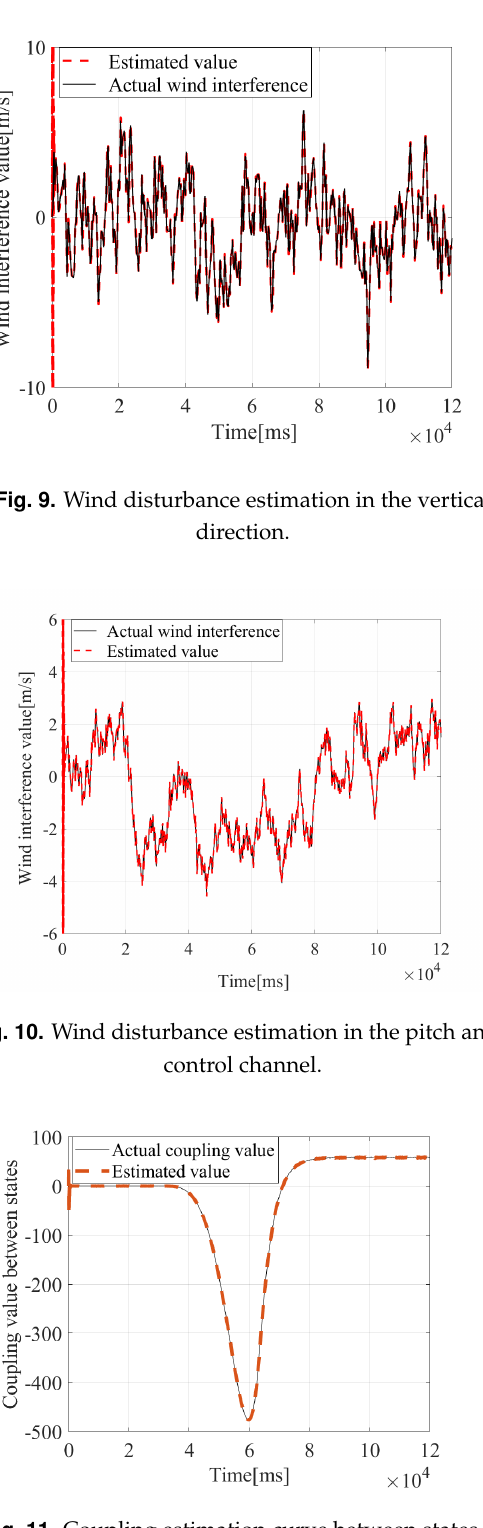
Fig. 11. Coupling estimation curve between states of horizontal direction.